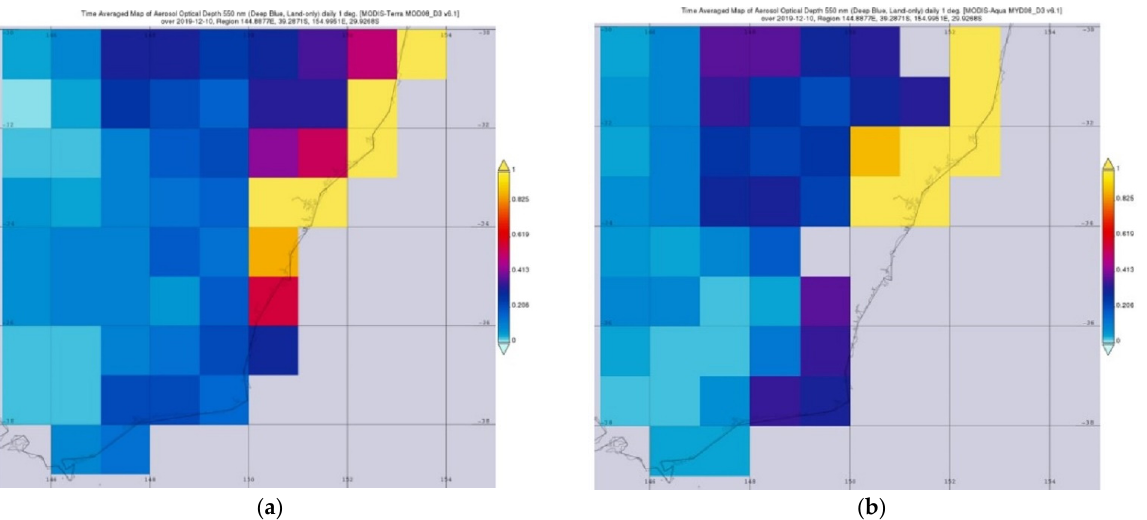
Figure 8. ( a ) AOD as measured at 550 nm by the Terra sensor, and ( b ) the Aqua sensor on the MODIS satellite on 10 December 2019 (https://giovanni.gsfc.nasa.gov/giovanni/ (accessed on 20 January 2020)).